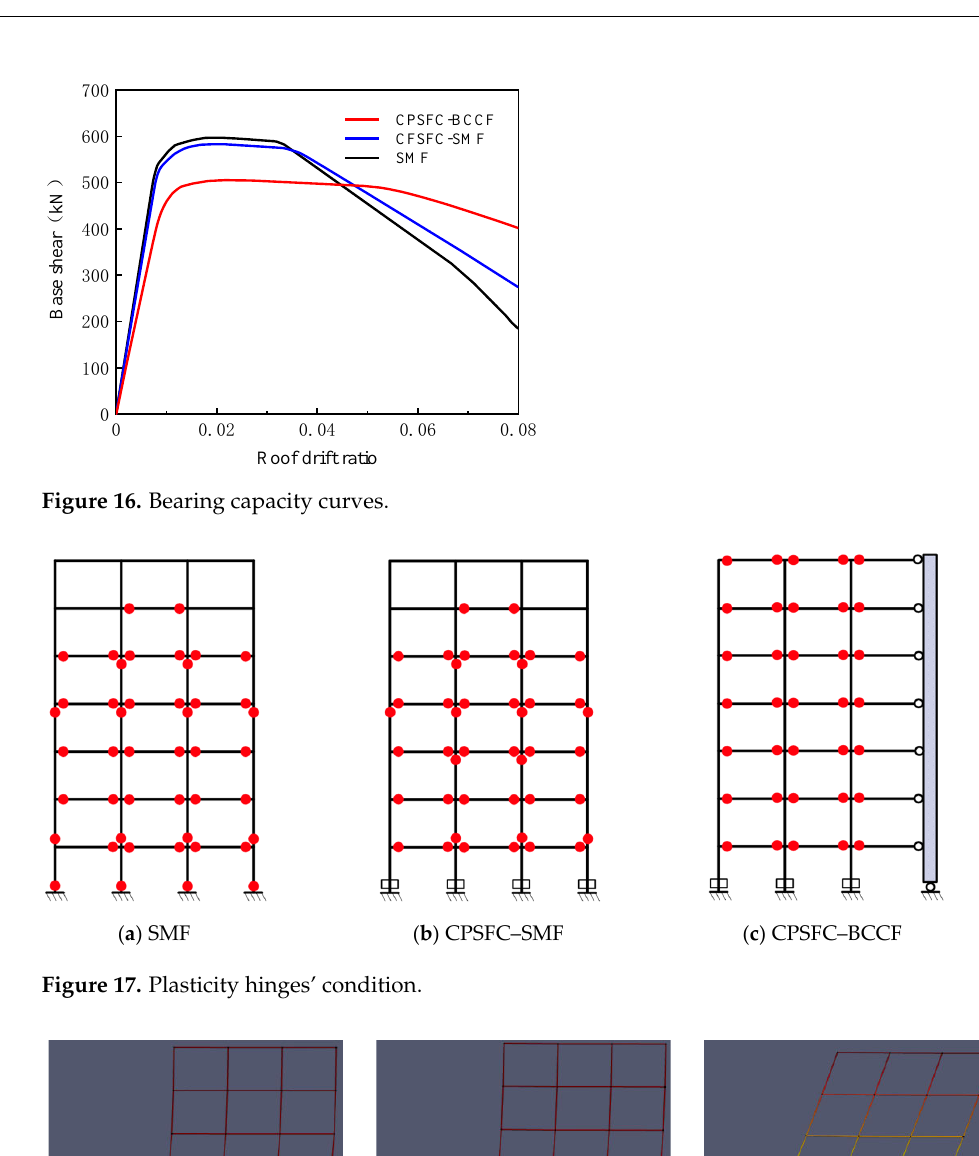
Figure 16. Bearing capacity curves.